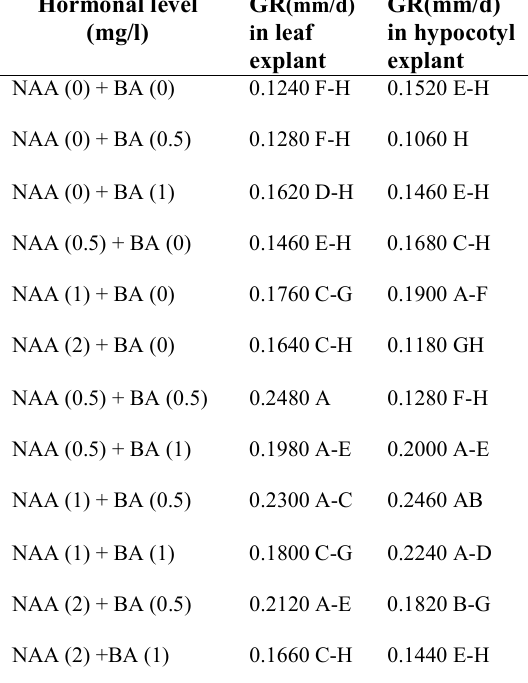
Table 3 . Mean comparison for interaction effects of explant × hormone concentrations on callus growth rate in Cuminum cyminum L. GR: growth rate. Similar letters in the tables showed that they didn’t have any significant statistical difference in 0.05